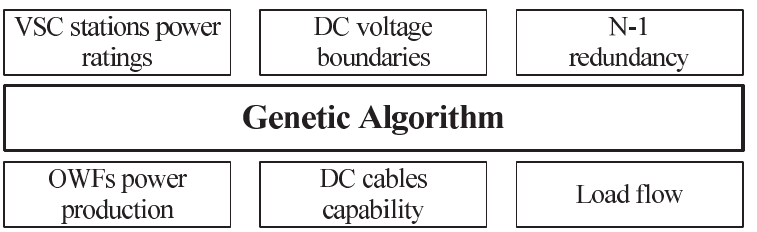
Figure 9. Constraints incorporated in the genetic